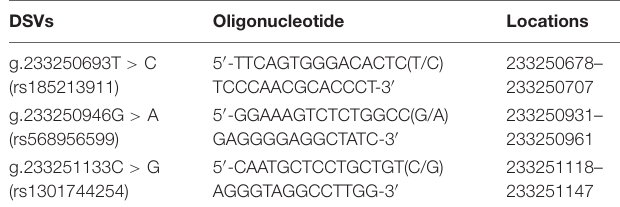
TABLE 4 | The double-stranded biotinylated oligonucleotides for the